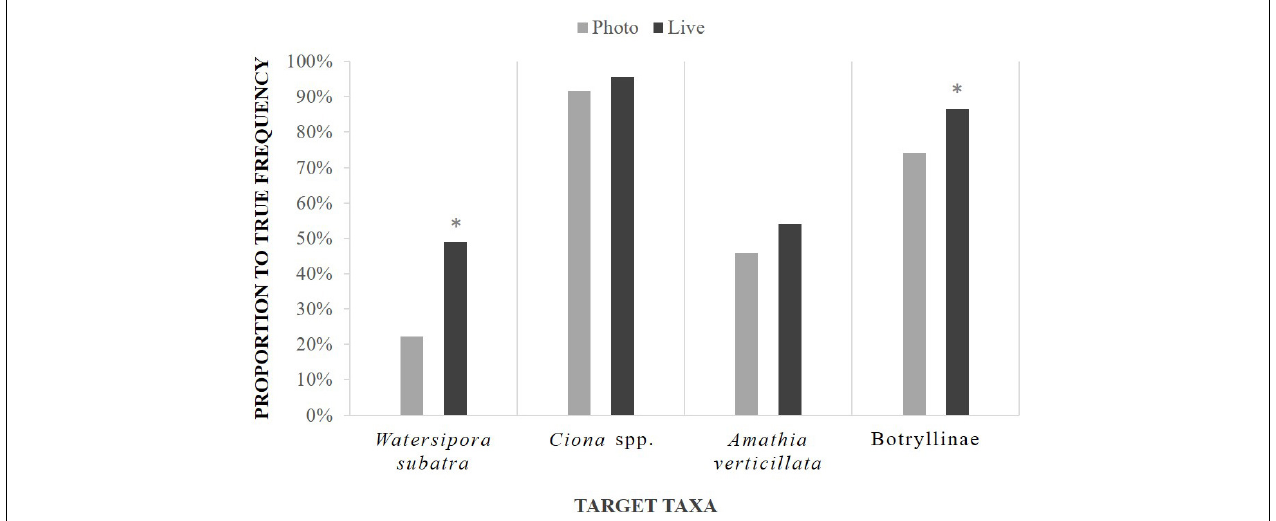
FIGURE 5 | Target taxa detection rate, shown as frequency found per point count method compared to true frequency, with asterisks that denote statistical differences between method for each target